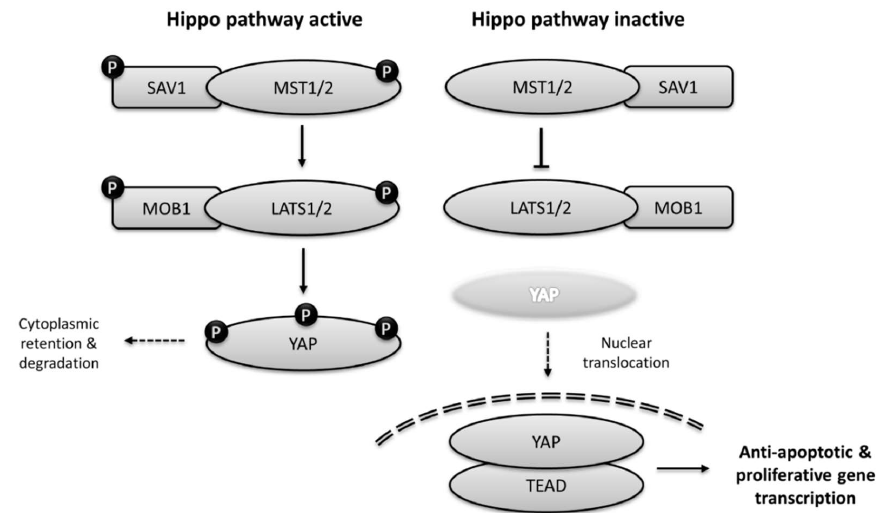
Figure 1. The core components of the mammalian Hippo signalling pathway. When active (left) Mammalian Ste20-like kinases (MST kinases) phosphorylate Salvador (SAV1) and downstream MOB kinase activator 1 (MOB1) and Large tumour suppressor (LATS) kinases, leading to phosphorylation and degradation of Yes-associated protein (YAP). When upstream kinases are inactive (right), non-phosphorylated YAP resides in the nucleus and binds to transcription factors to promote pro-survival and anti-apoptotic gene